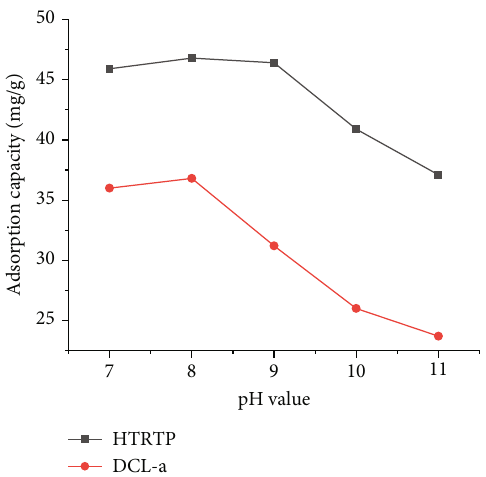
Figure 6: E ff ect of pH value on adsorption quantity of DCL-a and